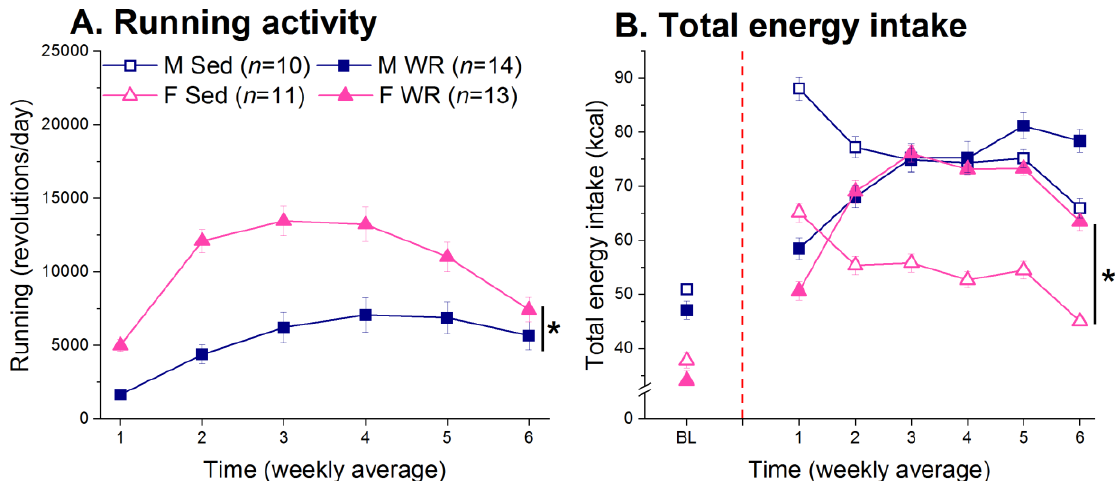
Figure 4. Running activity and total energy intake. ( A ) Female rats ran more than males, and both sexes showed and inverted-U trend in running activity. * Male vs. female, p < 0.05. ( B ) Female, but not male, running rats had higher energy intake than their Sed counterparts. * Sed vs. WR, p < 0.05.